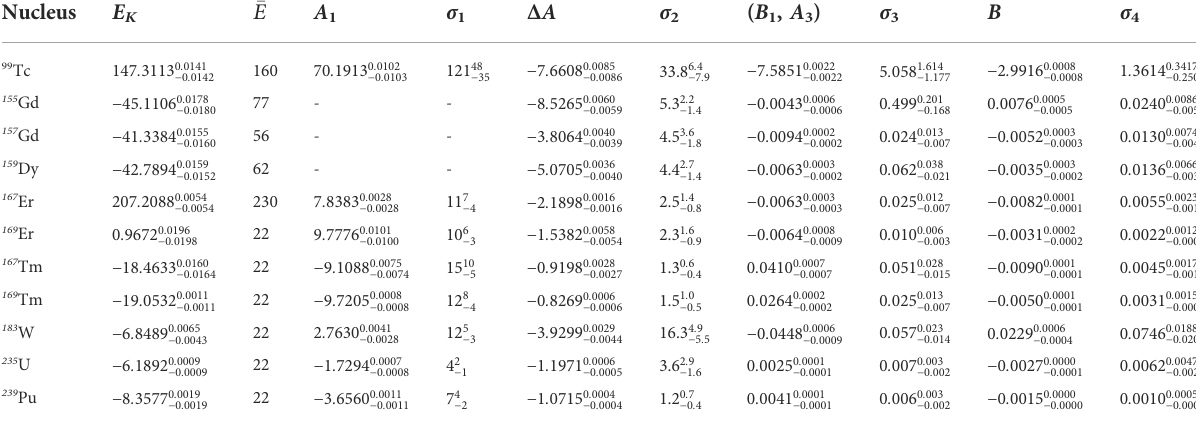
TABLE1ThemedianvalueoftheLECsatN 4 LOcomparedwiththestandarddeviationoftheirGaussianpriorswithzeromean[see Eq.15].Weseethat, for nearly all cases, the LECs fall within this standard deviation. The uncertainties encompass the 16th and 84th percentiles of the samples in the marginalized distributions. K =3/2 rotational bands do not have a parameter A 1 and the parameters ( B 1 , A 3 ) refer to K =1/2 and K =3/2 bands respectively. All the numbers are in units of keV. Nucleus